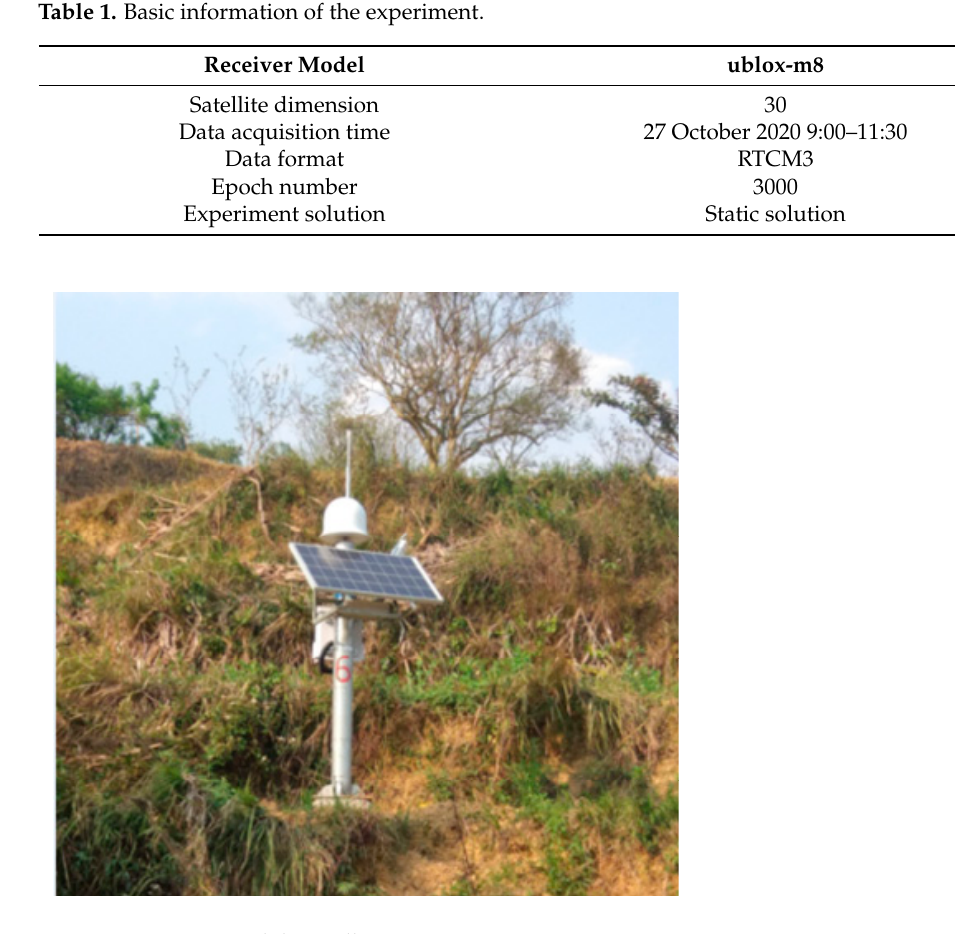
Figure 5. Simulation diagram of ambiguity search time of three algorithms.